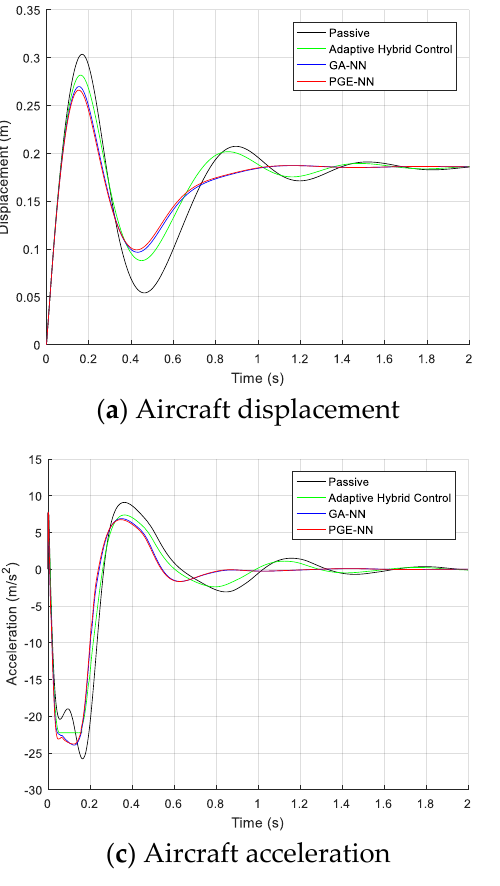
Figure 10. Comparative simulation results of the passive damper, adaptive hybrid controller, GA-NN, and PGE-NN control at m 1 = 680 kg, v = 3 m/s.